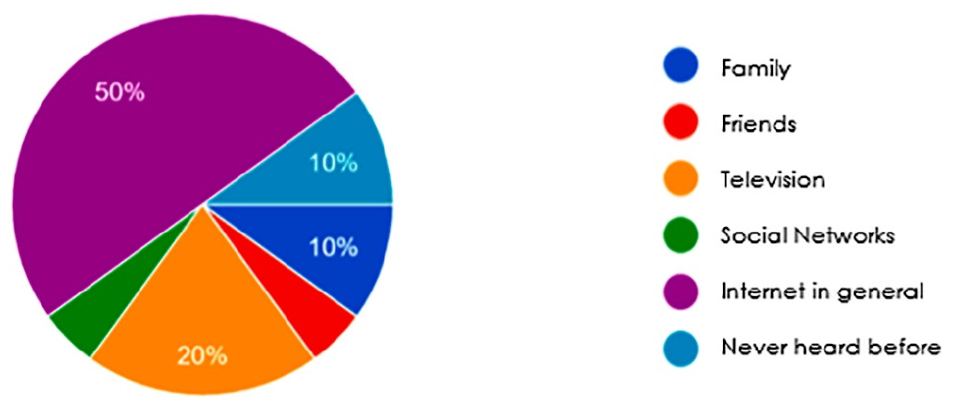
Figure 13. Origin of the knowledge of SDGs.